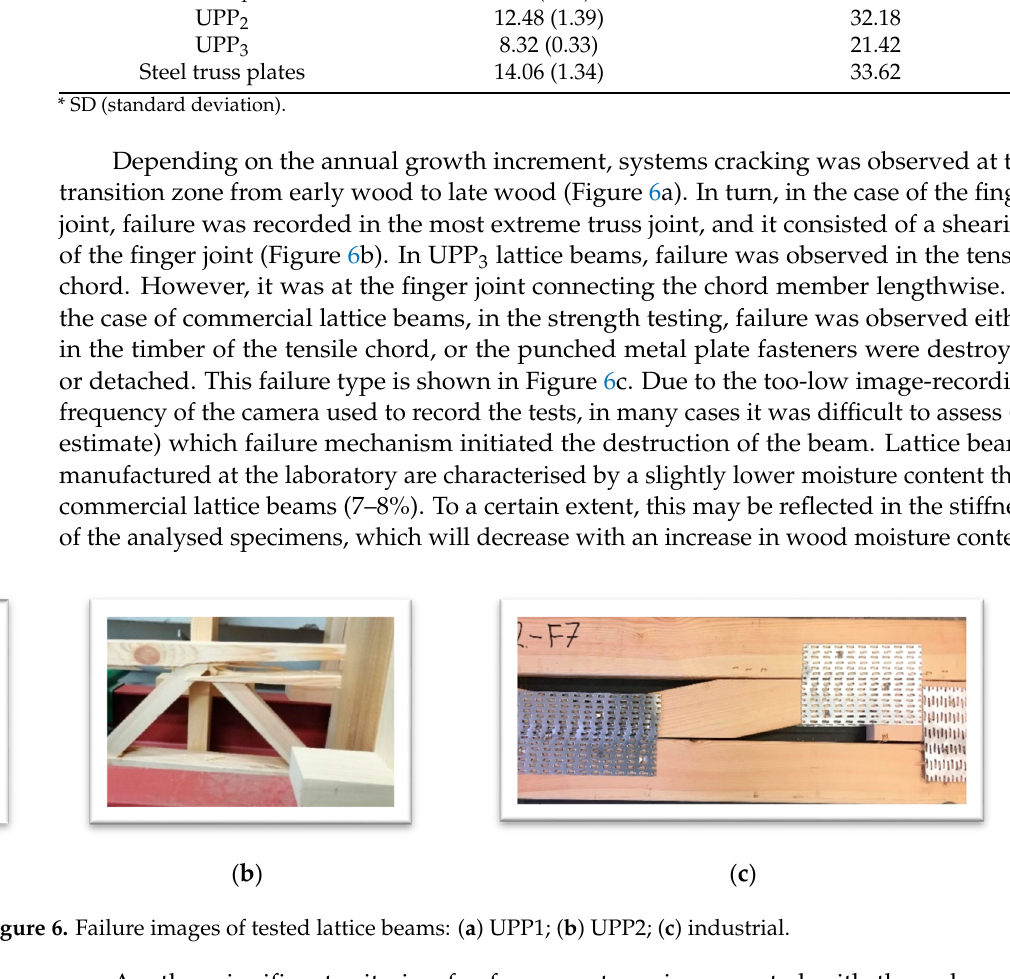
Table 6. Evaluation of the mechanical properties of manufactured models of lattice beams.